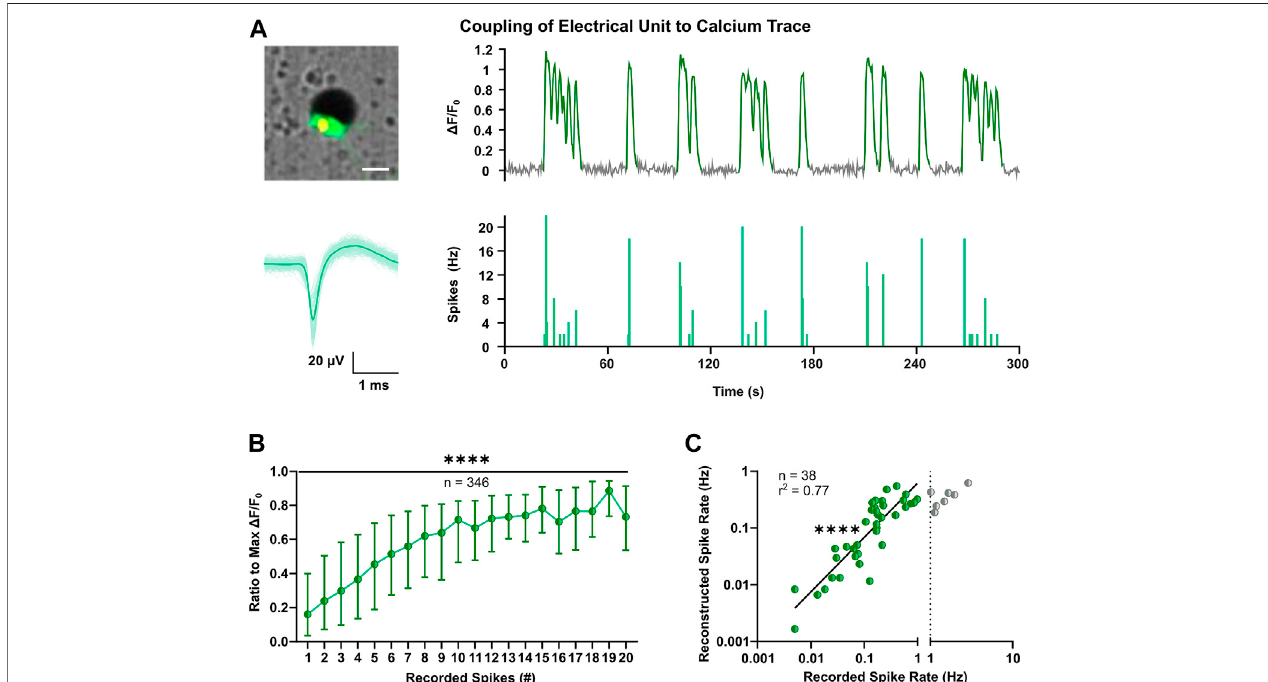
FIGURE 3 | Optimization of spike inference based on coupling of extracellular voltage signals to intracellular calcium transients. (A) Representative example of coupling of the calcium trace (top-right) of a single neuron close to an electrode (top-left) and the corresponding electrophysiological signals. Superimposed waveforms and their mean (solid line) are shown on the bottom-left, whereas on the bottom-right the respective spike count histogram with bin size of 0.5 s is shown. Image scale bar represents20 µm. (B) Comparison between electrically recorded spikes and GCaMP6s fl uorescence, indicated as ratioto the max Δ F/F 0 (Kruskal-Wallis test). Median andIQRareshown. (C) Correlationbetweenmeanspike ratesrecordedwithMEAand inferred throughMLspikealgorithmwith fi ttedparameters(Ftest).Values are log-transformed and axis show anti-log scale. Line indicates simple linear regression. **** p < 0.0001.